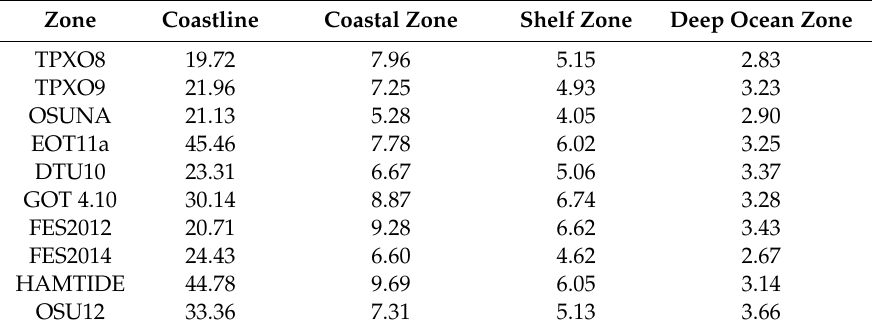
Table 4. The mean RSS values (in cm) for the four major tidal constants for the tidal models over coastline (CL), coastal zone (CZ), shelf zone (SZ) and deep ocean zone